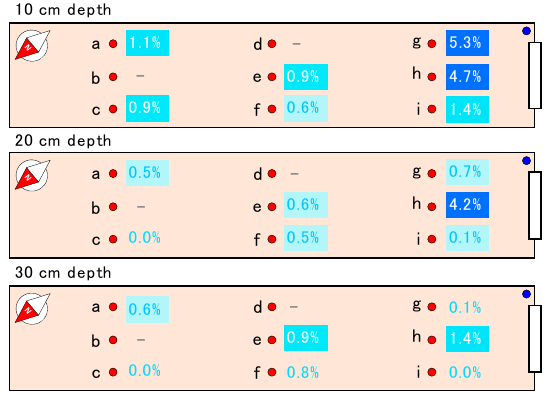
Figure 9. Distribution of the increase in soil moisture at the mizuna greenhouse after irrigation on 29